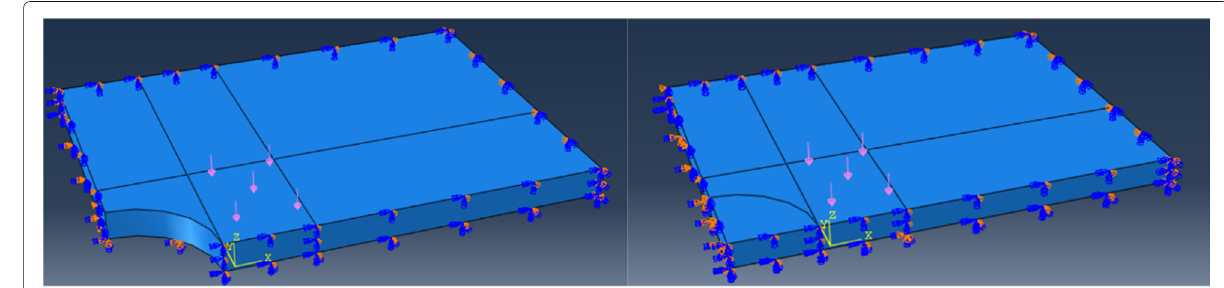
Fig. 1 Model of static simulation with filled and unfilled pothole